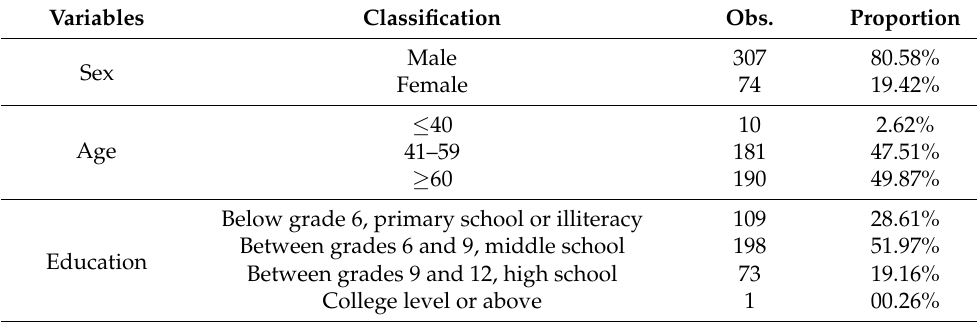
Table 2. Basic characters of surveyed